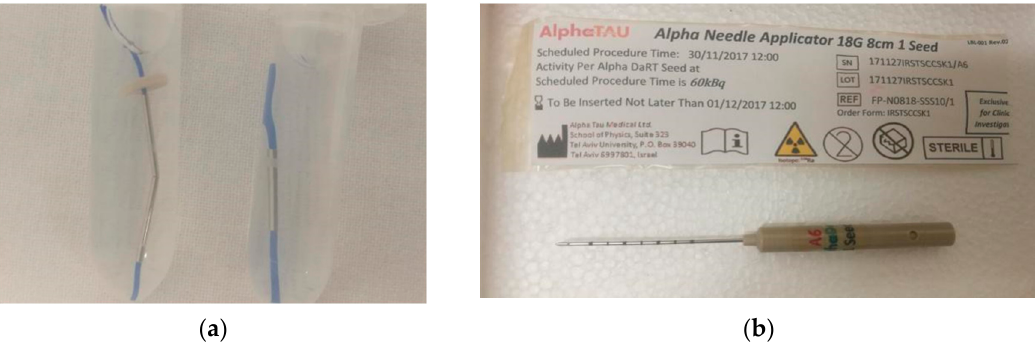
Figure 1. Image of 2-cm and 1-cm long DaRT 224-Ra source seeds ( a ) and needle applicator for seeds insertion ( b ).